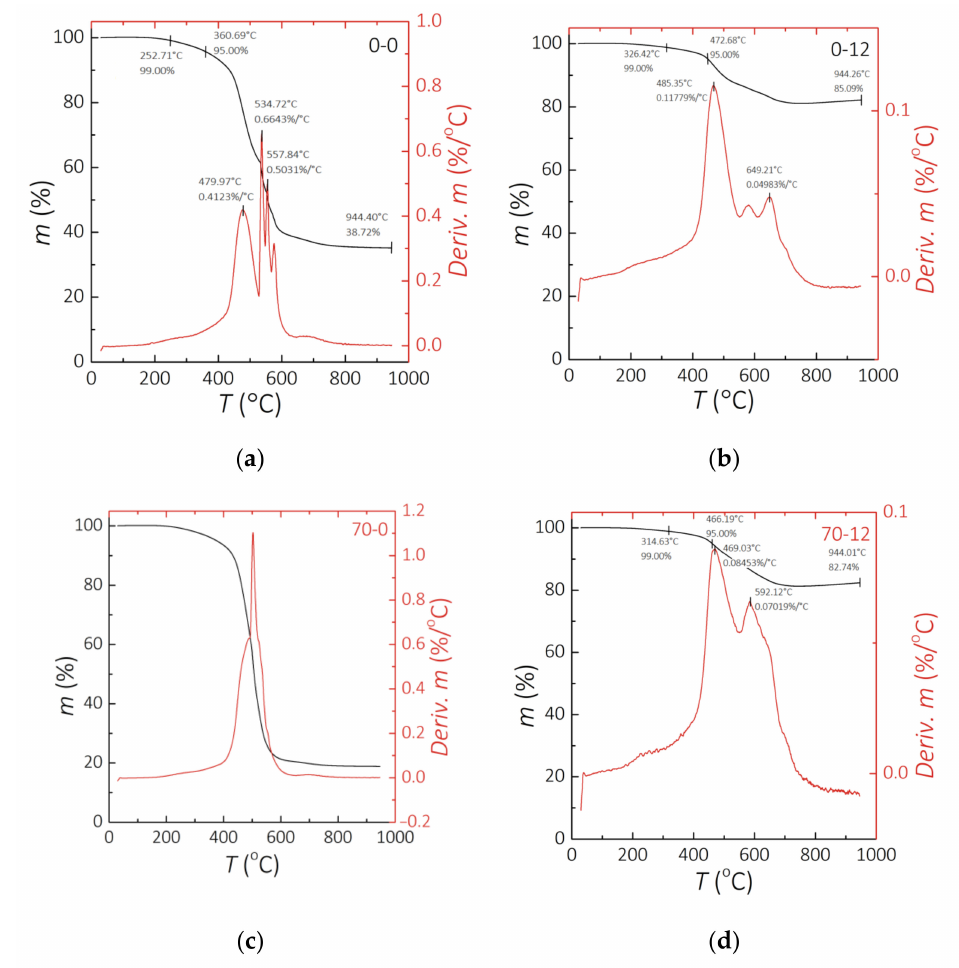
Figure 4. Results of the TG analysis. ( a ) 0-0 sample. ( b ) 0-12 sample. ( c ) 70-0 sample. ( d ) 70-12